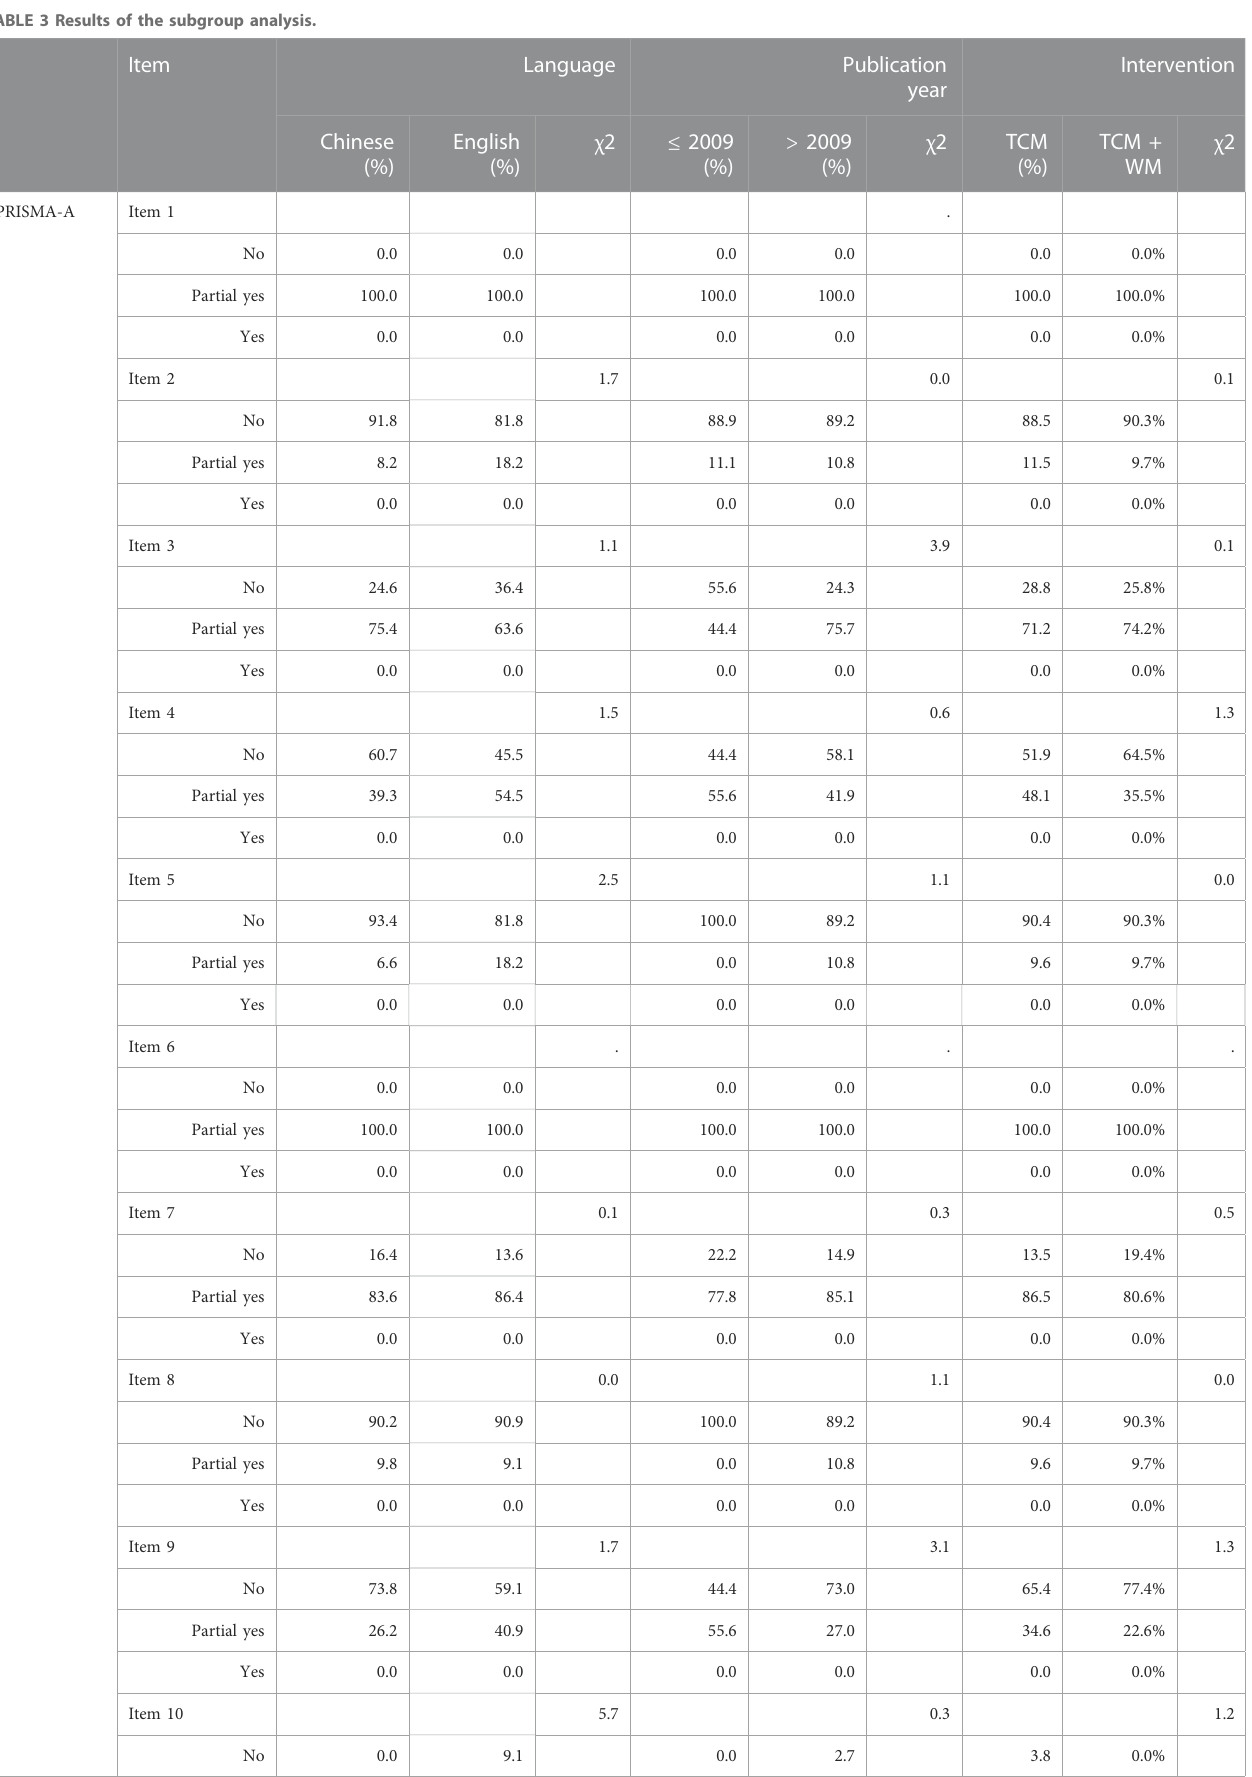
TABLE 3 Results of the subgroup